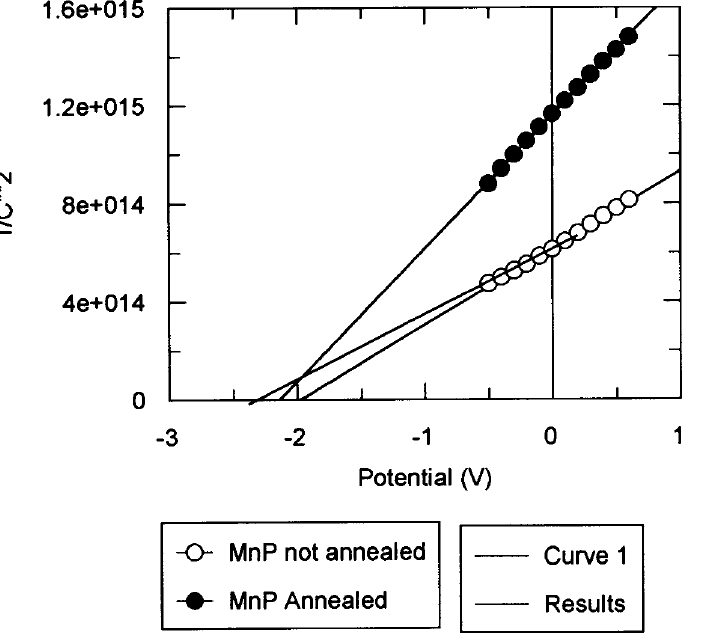
FIGURE 5 Effect of annealing the MnP = polymer-modified n-GaAs electrodes in Mott-Schottky plots under room light. Plot (a) for the annealed electrode shows a better and more linear than plot (b) with no annealing. All measurements were conducted in water = LiClO 4 = Fe(CN) 3 (cid:2)